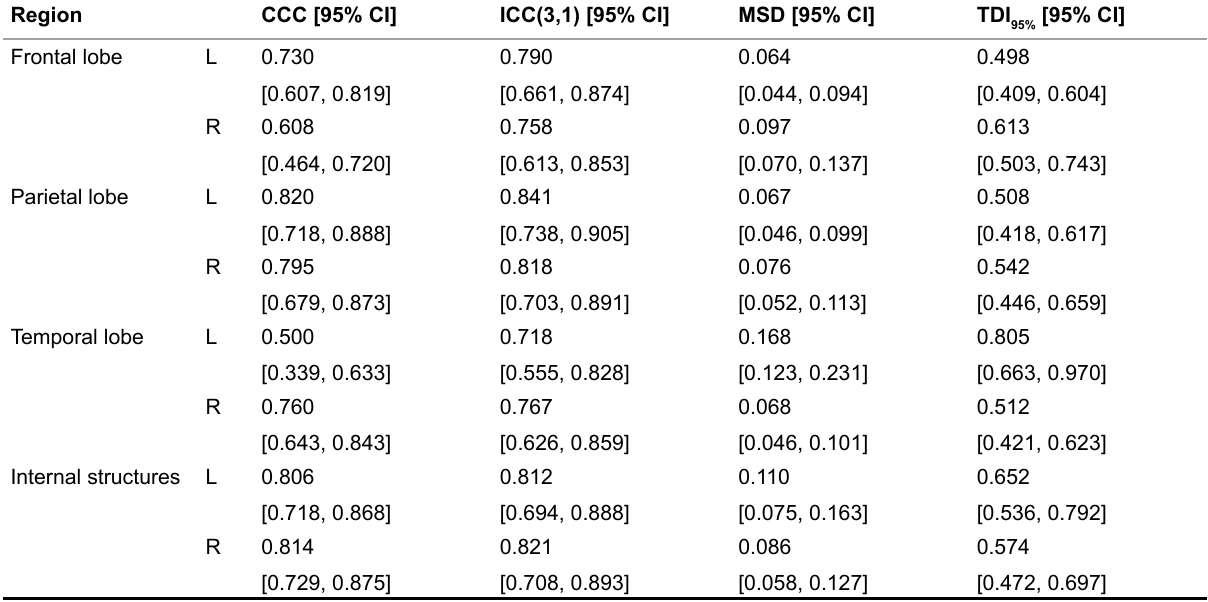
Table 5. Scaled (CCC, ICC) and unscaled (MSD, TDI) agreement metrics and 95% CIs calculated between CereMetrix ® data and MIMneuro ® data Region